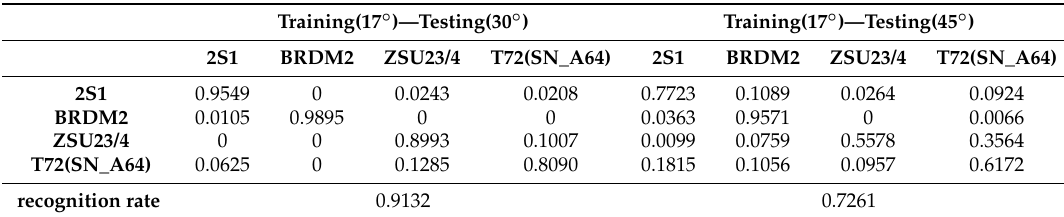
Table 17. The result of SVM based on SAR-HOG under EOC_d.